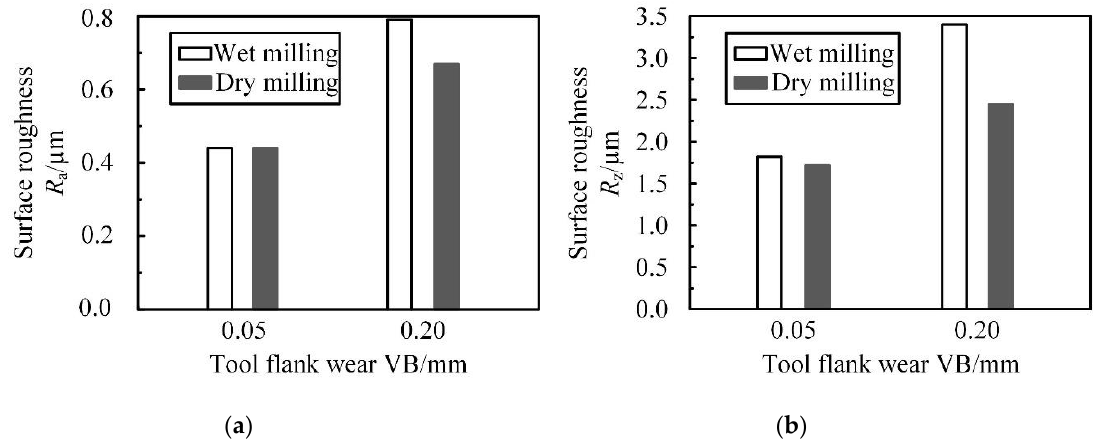
Figure 4. Effect of cooling conditions on surface roughness (tool flank wear: VB = 0.05 mm, VB = 0.20 Figure 4. E ff ect of cooling conditions on surface roughness (tool flank wear: VB = 0.05 mm, mm). ( a ) R a, ( b ) R z. VB = 0.20 mm). ( a ) R a, ( b ) R z.